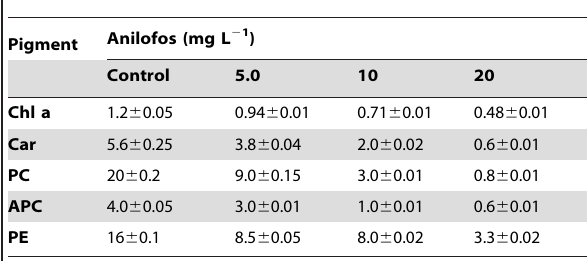
Table 1. Amount of photosynthetic pigments (mg L 2 1 ) of Synechocystis sp. strain PUPCCC 64 in anilofos-grown cultures at day